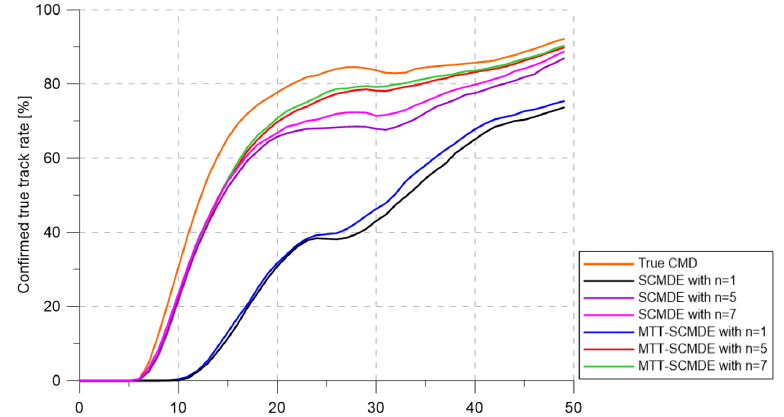
Figure 13. Confirmed true track